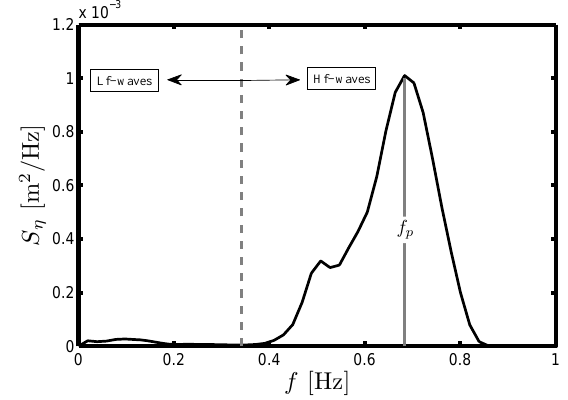
Fig. 3. Definition of peak wave frequency ( f p ), low-frequency (lf-) and high-frequency (hf-) waves for a given offshore wave spectrum.